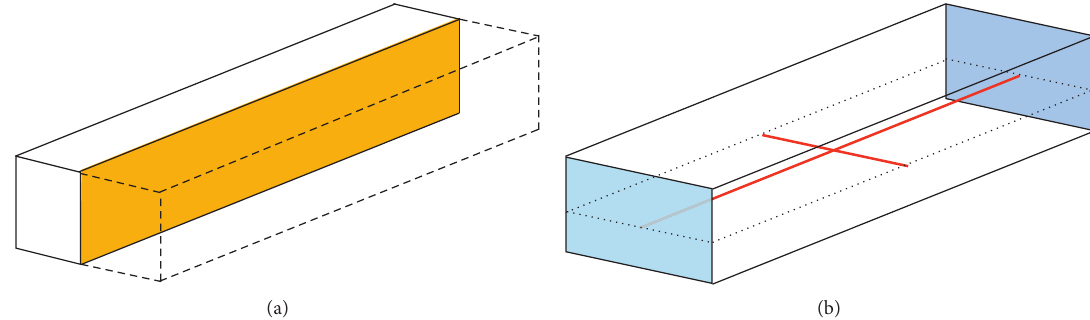
Figure 8: Boundary conditions forcing mode of interest: (a) symmetry plane promoting flexural vibration and (b) fixed axes promoting torsional vibration and a constraint equation limiting motion of the two extremities of the specimen to rotate in opposite directions.